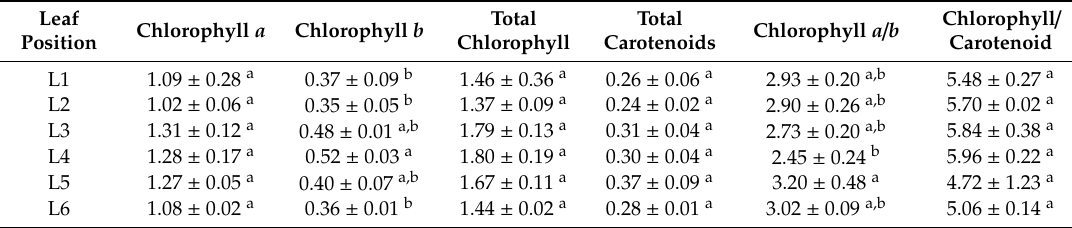
weight per fresh weight leaf (mg g − 1